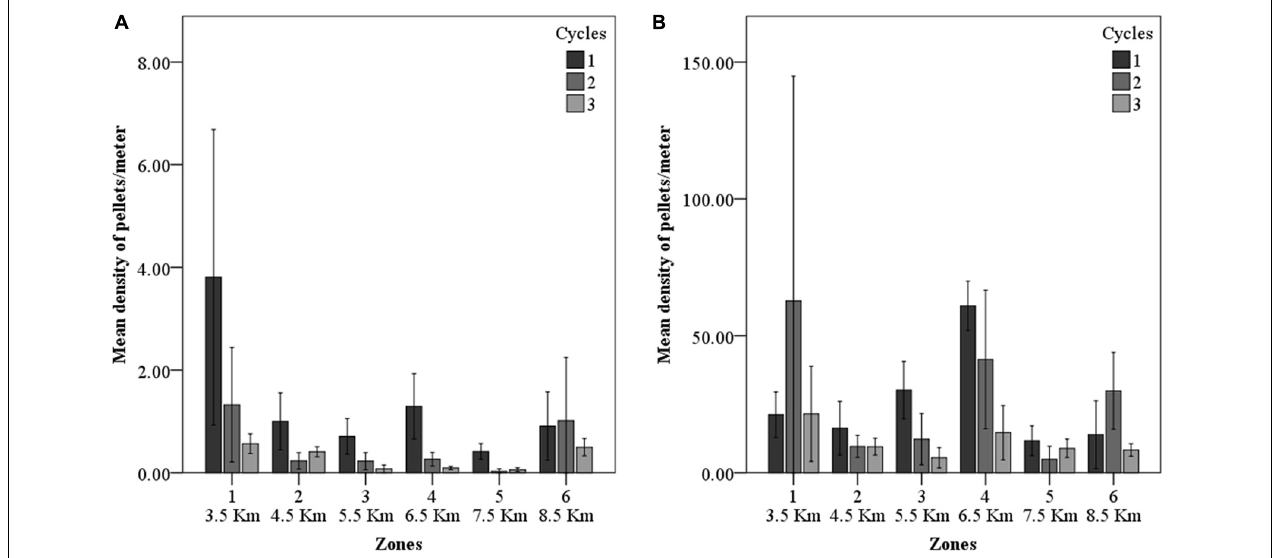
FIGURE 4 | Estimates of plastic pellet inputs to sandy beaches at the “local-scale” during; (A) the onset of the rainy season (November), and (B) at the end of the rainy season (March). Data are grouped by zones (with increasing distance from the Santos channel in x -axis) and by consecutive tidal cycle (following mean high tide of spring). The bars represent mean ( ± SE) for each sampling zones.